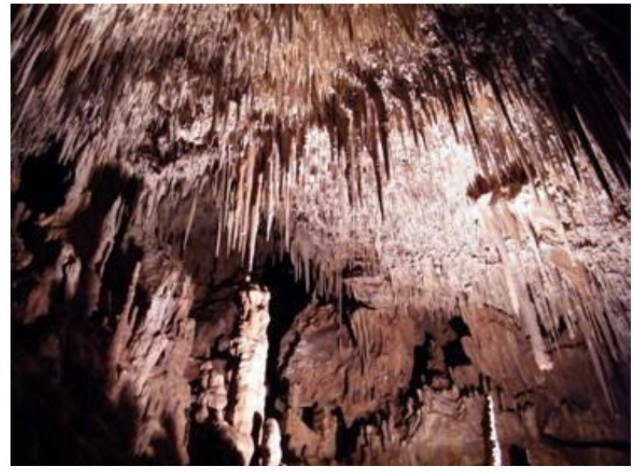
Figure 1. Formation of Stalactites inside cave Agios Athanasios, Central Thessaly,